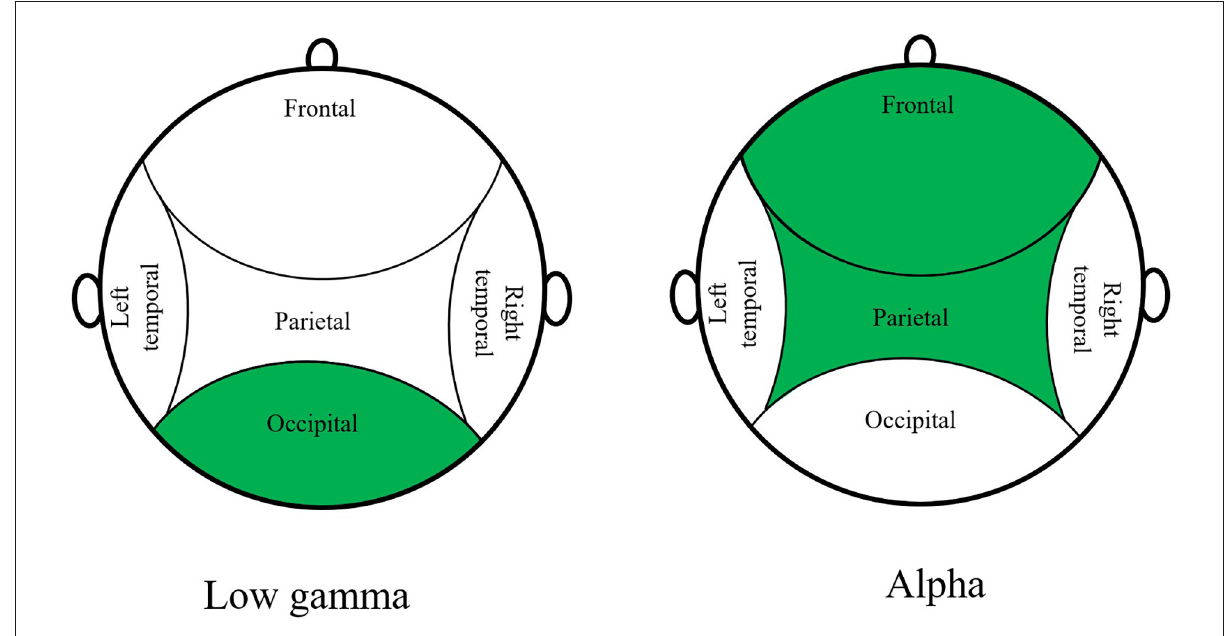
FIGURE4 Top 3 EEG features to classify BL from the experiment.